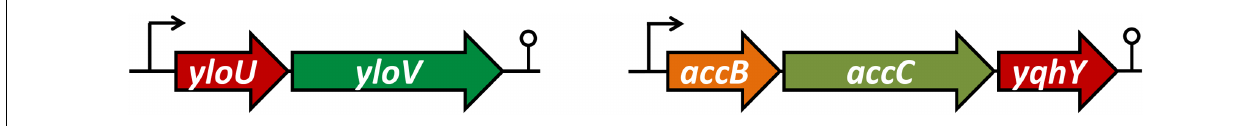
FIGURE 1 | Genetic context of yqhY and yloU . The genes are located in two distinct operons together with genes encoding proteins involved in fatty acid metabolism. yqhY clusters with accB (biotin carboxyl carrier protein) and accC (biotin carboxylase subunit). yloU forms an operon with yloV .